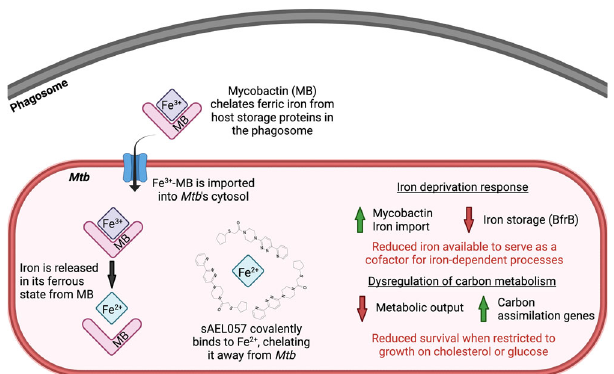
Fig. 6 Proposed model for sAEL057 mode of action. Mycobactin (MB) chelates ferric iron (Fe 3 + ) from host storage proteins inside the phagosome. Iron-laden mycobactin is imported into the bacterial cytosol through the IrtA/B transporter. Ferric iron is reduced to ferrous iron (Fe 2 + ) to facilitate release from mycobactin. Nitrogen atoms of